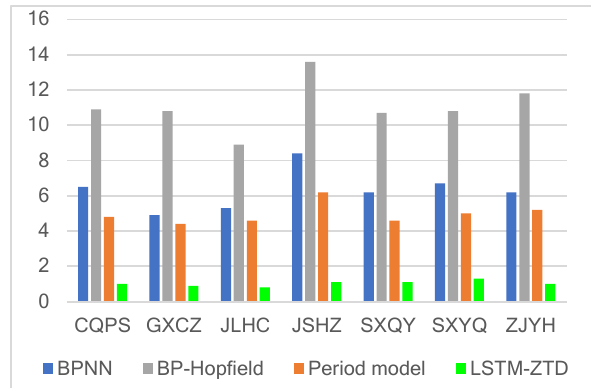
Figure 10. RMS error (cm) comparison of different forecasting models.